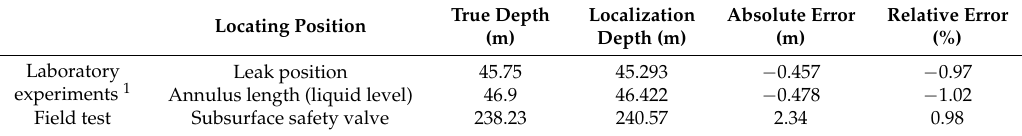
Table 5. Comparison of localization errors in the laboratory and field